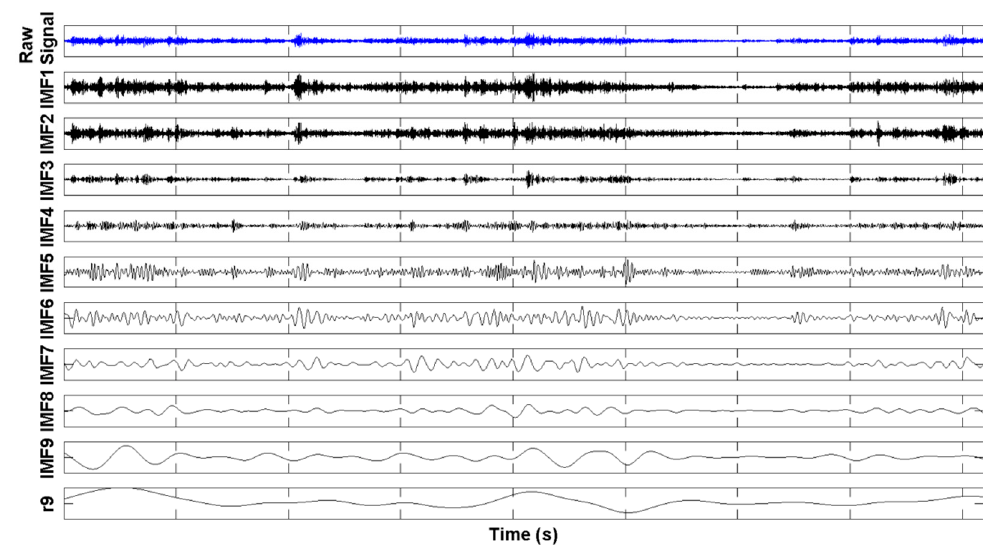
Figure 9. The raw signal and the ensemble empirical mode decomposition (EEMD) signal results in time domain.